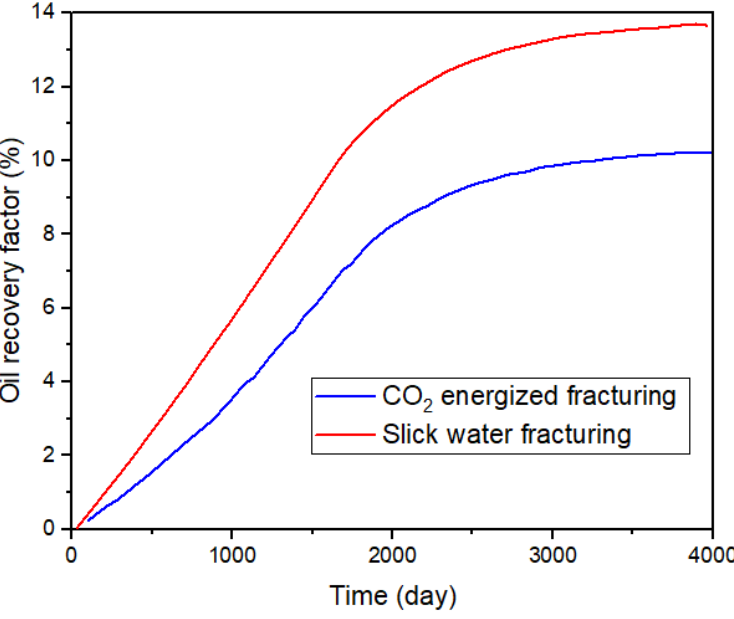
Figure 5. The comparison of oil recoveries under different fracturing